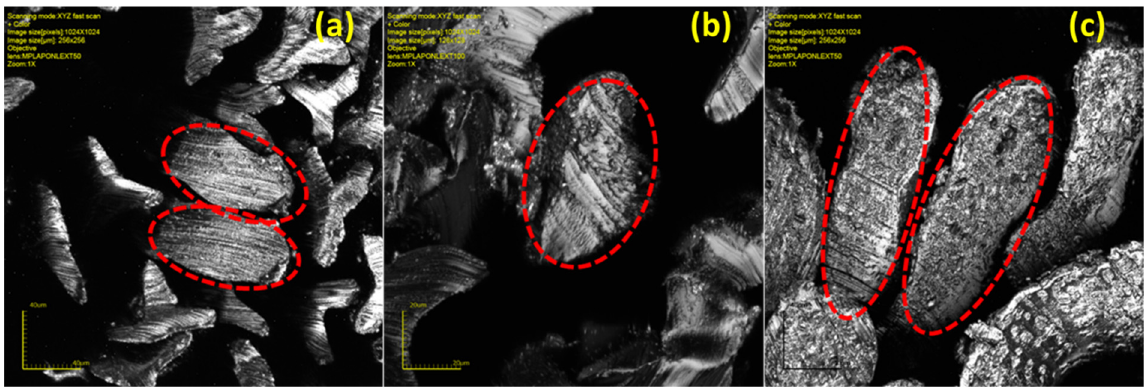
Figure 5. Confocal micrographs of ( a ) Lig3/PVA7, ( b ) Lig5/PVA5, and ( c ) Lig7/PVA3 fibers.